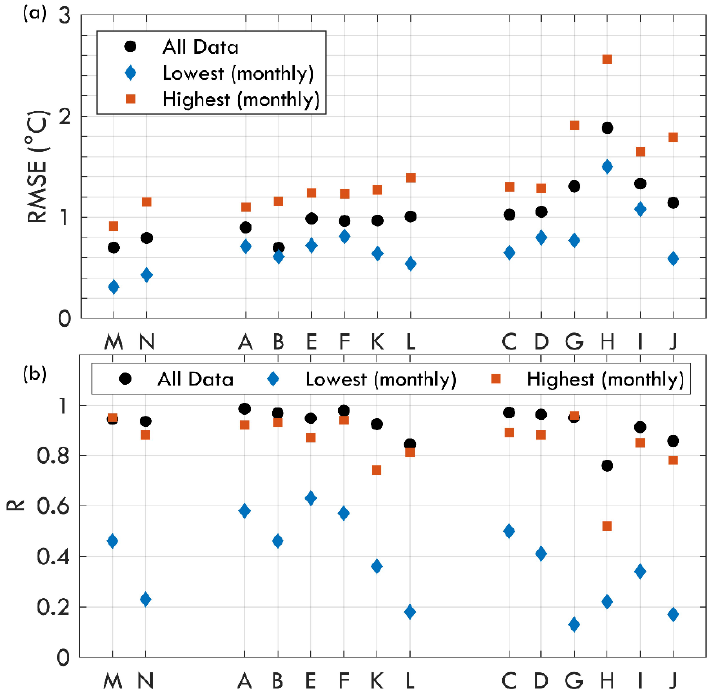
Figure 6. The (a) RMSE and (b) correlation between each buoy bulk SST and satellite skin SST on monthly time scales. The black dots (all data) refer to all bulk-skin SST pairs at each location. In addition, all the data at each location are divided into 12 months. The red and blue dots are the highest and lowest values on the monthly time scale, respectively.